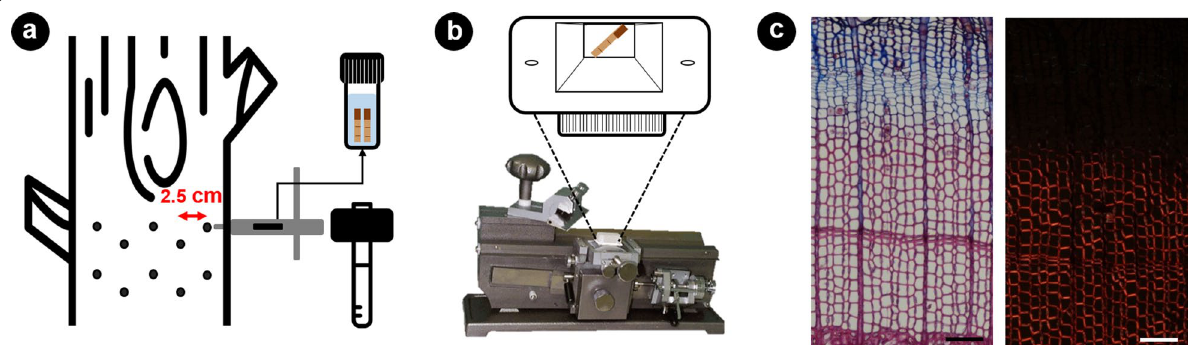
Fig. 3 Sample preparation process. a collection of micro‑samples using a Trephor, b cutting a cross‑section of the embedded micro‑samples in PEG2000 (polyethylene glycol 2000) using a sliding microtome of thickness 6–12 μm, and c observation of thin sections under light (left) and polarized microscopes (right) to identify the cambial zone and xylem cells during enlarging, cell‑wall thickening, and mature phases (scale bars, 100